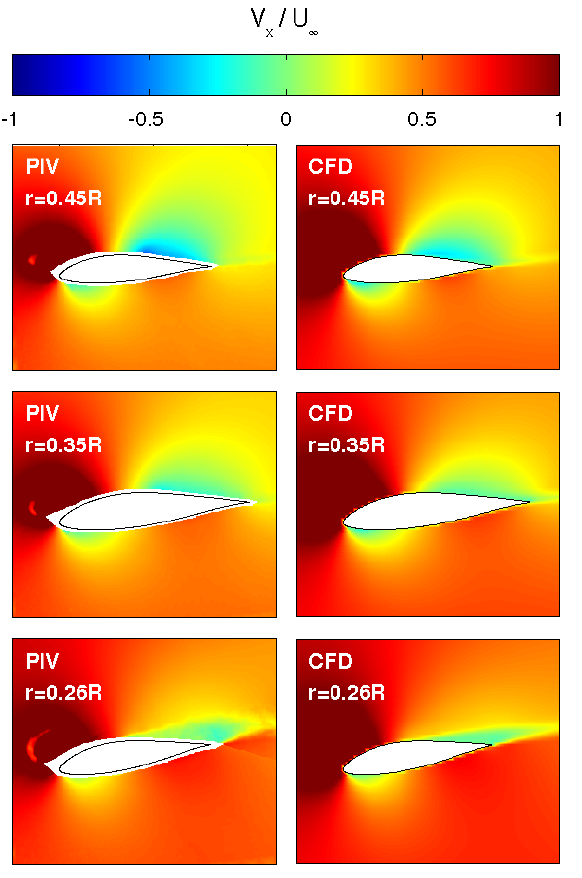
Figure 7. Experimental and numerical results of the radial velocity component at different blade spanwise